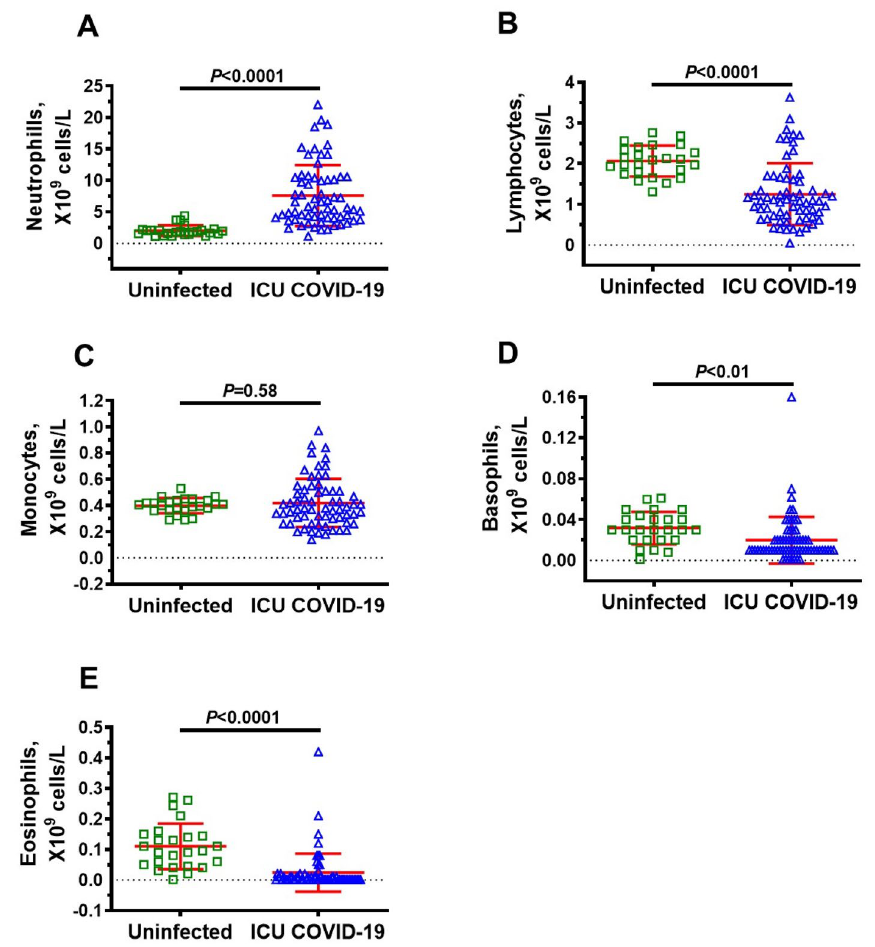
Figure 3. Plasma levels of neutrophils, lymphocytes, monocytes, basophils and eosinophils in uninfected control and ICU COVID-19 patients. ( A ) Neutrophils levels were significantly higher in ICU COVID-19 patients than that in uninfected controls. ( B ) Lymphocytes levels were significantly lower in ICU COVID-19 patients than that in uninfected controls. ( C ) Monocytes levels in ICU COVID-19 patients were not significantly different from uninfected controls. ( D , E ) Basophils and eosinophils levels were significantly lower in ICU COVID-19 patients compared to uninfected controls, respectively. Data shown are for each patient with mean ± S.E.M from n = 30 uninfected controls (26.6% females) and n = 65 ICU COVID-19 patients (29.3% females). Statistical significances are shown above sets of data points on the